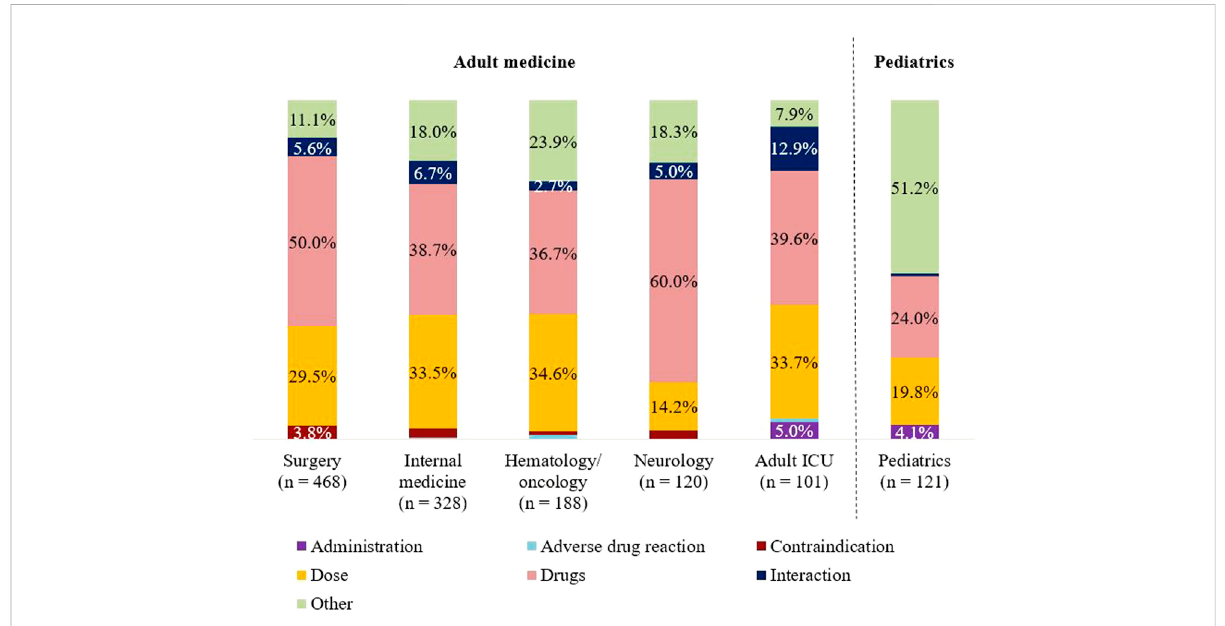
FIGURE 1 Classi fi cation of reasons for PIs: Sorting of specialties (adult vs. pediatrics) by descending number of